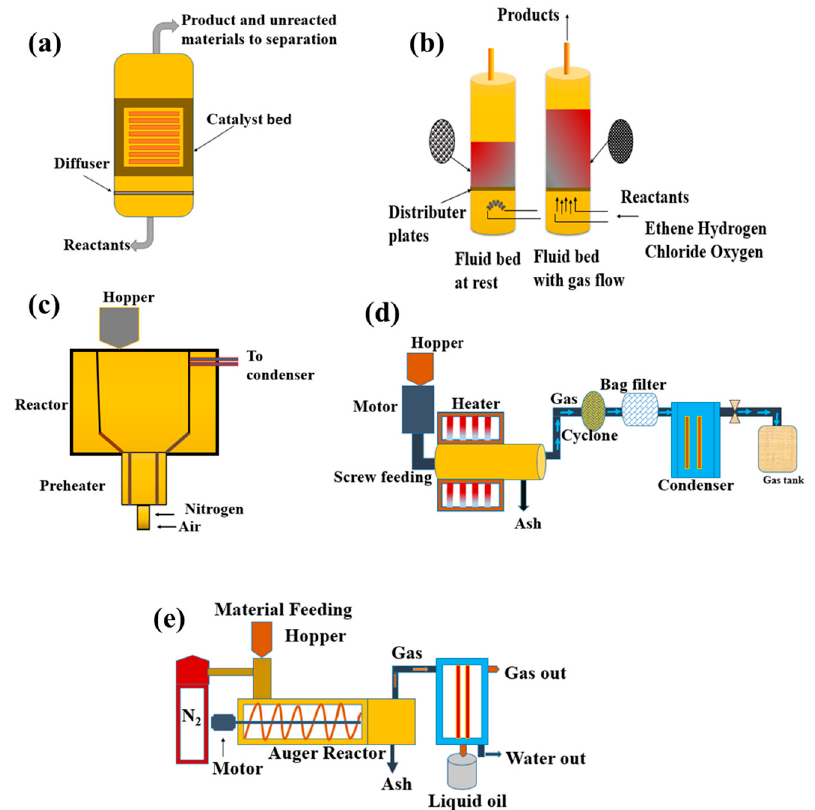
Figure 4. Type of reactor: ( a ) fixed-bed reactor, ( b ) fluidized-bed reactor, ( c ) conical spouted-bed reactor, ( d ) rotary kiln reactor, ( e ) auger reactor.